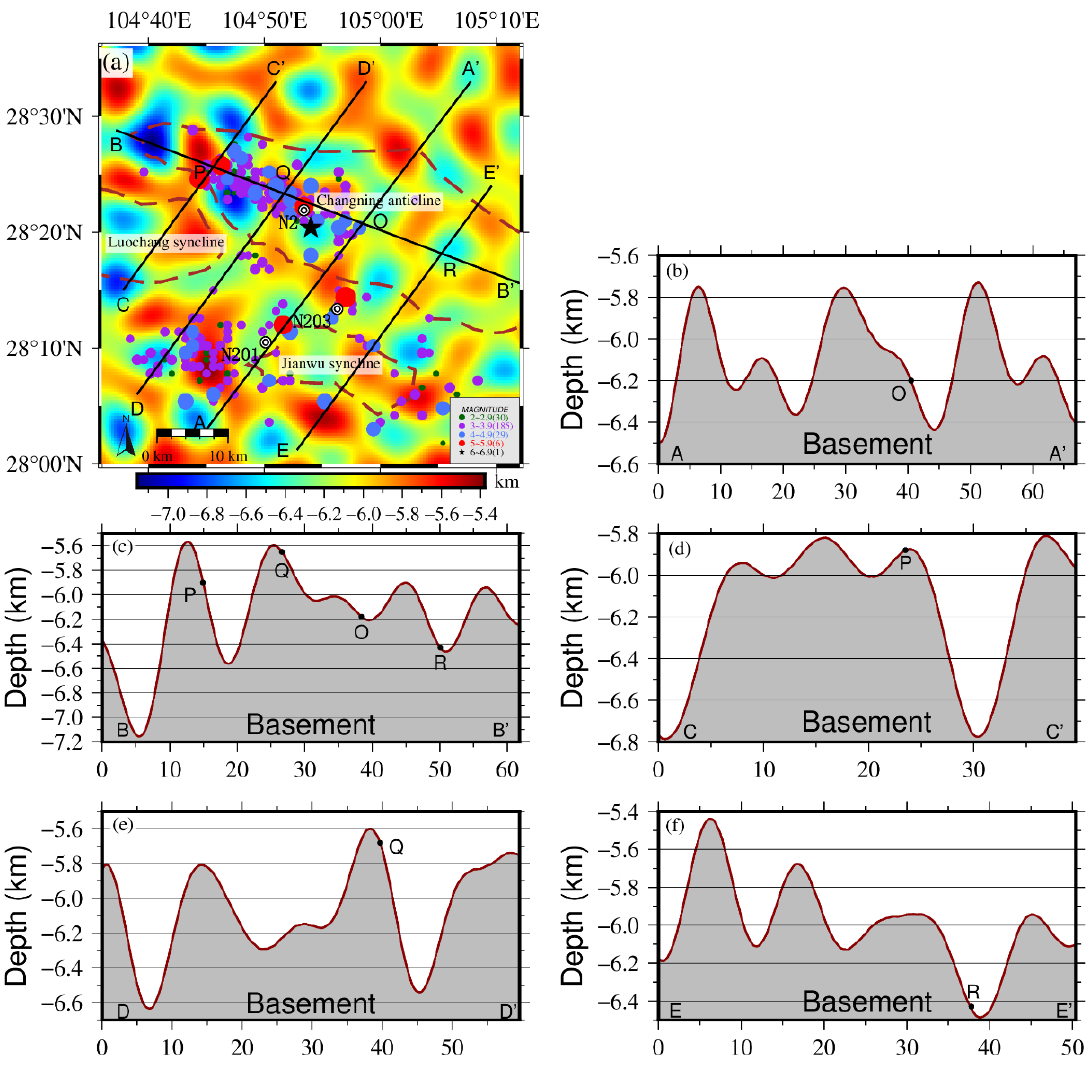
Figure 7. Profiles of magnetic basement relief map in the Changning area. The five black lines are the profiles in ( a ), corresponding to ( b – f ), respectively, and the intersection points are O, P, Q and R. The gray area is the magnetic basement in ( b – f ).